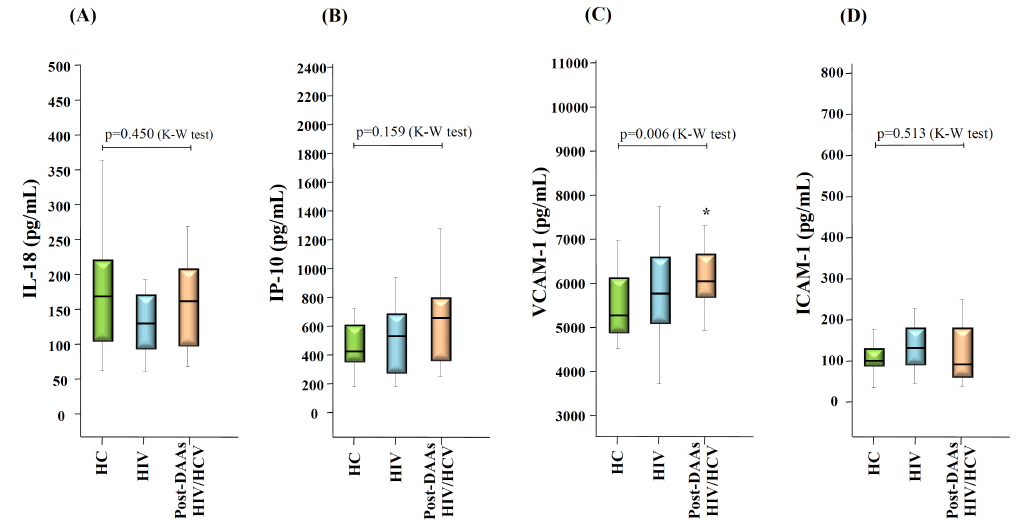
Figure 3. Box-plots graphs showing the levels of IL-18 ( A ), IP-10 ( B ), VCAM-1 ( C ) and ICAM-1 ( D ) in HC donors, HIV mono-infected, and HIV / HCV co-infected patients at 12 weeks after the end of DAAs therapy (post-DAAs HIV / HCV). p -values for the global comparison between the groups (Kruskal-Wallis test; K-W) are shown. ( * ): p < 0.05 with respect to the HC group (Mann-Whitney U test).